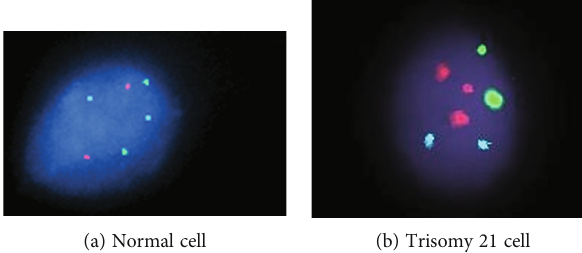
Figure 2: Representation of trisomy 21 through fl uorescent in situ hybridization technique. (a) Normal cell showing the signal pattern 2 red, 2 green, and 2 blue and (b) abnormal cell showing the signal pattern 3 red, 2 green, and 2 blue indicating trisomy 21 (Down syndrome).